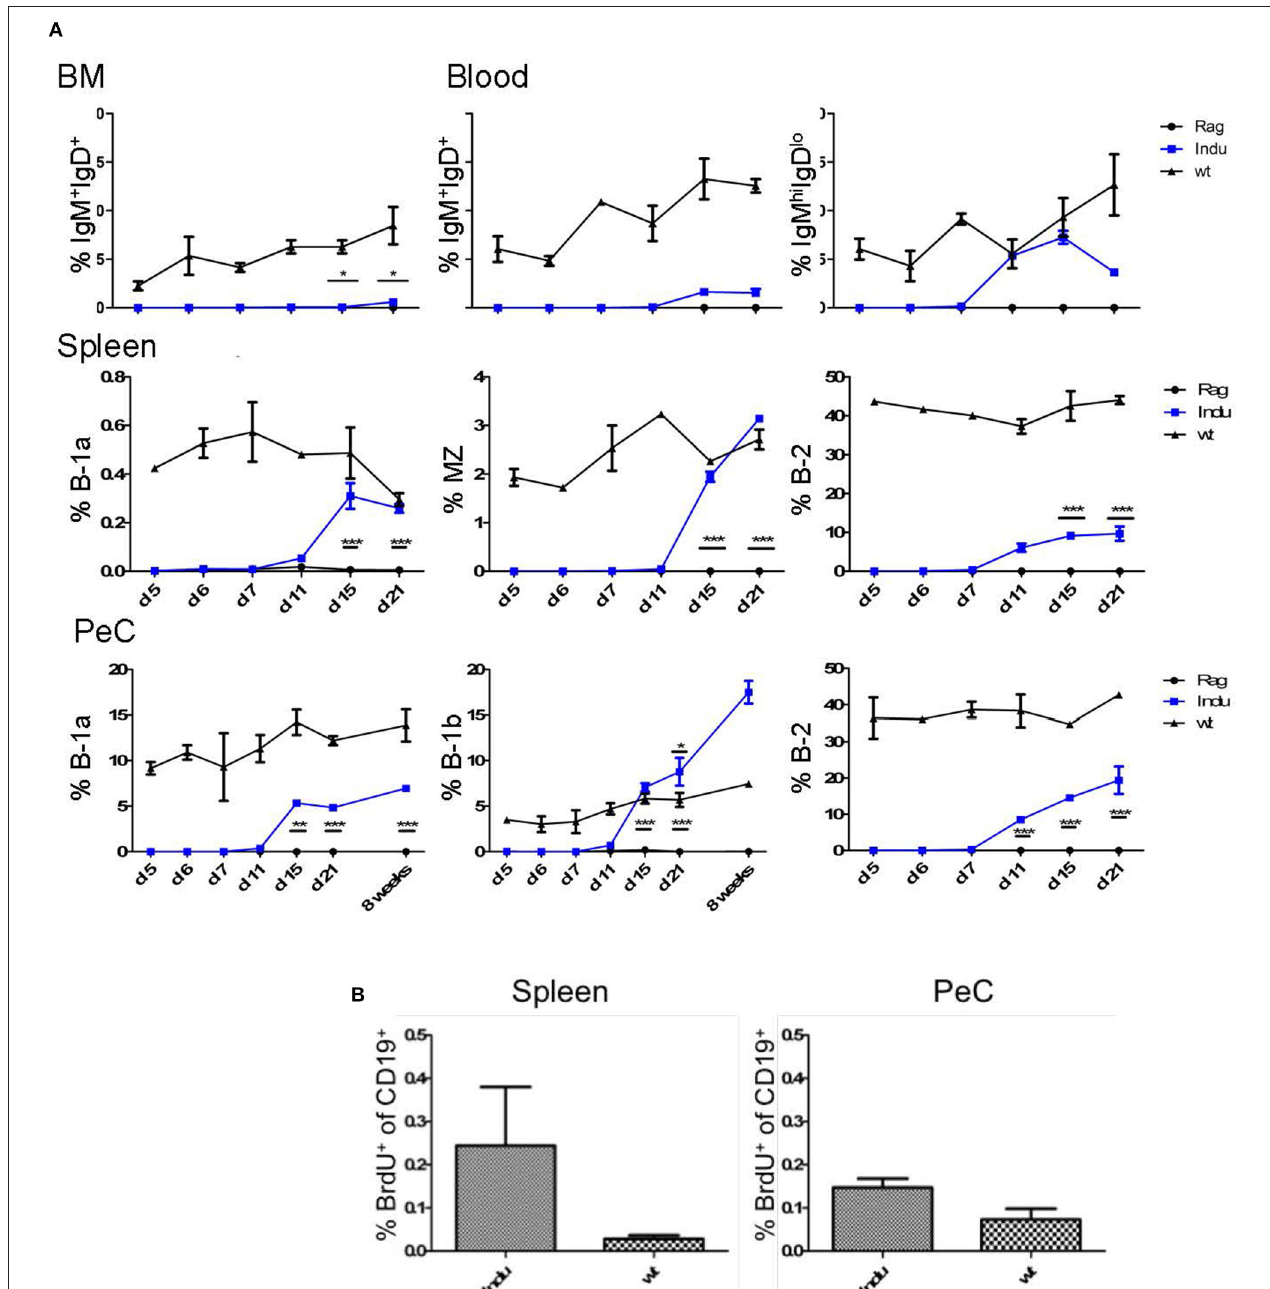
FIGURE 2 | BM-derived mature B cells rise over time in B-Indu-Rag1 mice after TAM-mediated induction of B lymphopoiesis. (A) Graphs depict the kinetics of newly generated BCR + B cell accumulation (IgM + IgD + , IgM high IgD low , B-1a, B-1b, B-2) at different anatomical sites [BM, blood, spleen, peritoneal cavity (PeC)], as indicated. (B) Cell proliferation of CD19 + B cells from spleen and peritoneal cavity of TAM-treated B-Indu-Rag1 (left) and Wt (right) mice, as revealed by BrdU incorporation in vivo . The proliferation of T1 was analyzed 9 days after induction. BrdU was given i.p. and 2h later the incorporation was analyzed by flow cytometric analysis. (A,B) Mean percentages ± SEM ( n ≥ 3 mice); asterisks in graphs indicate the level of significance (see methods for details). The experiments were carried out at least